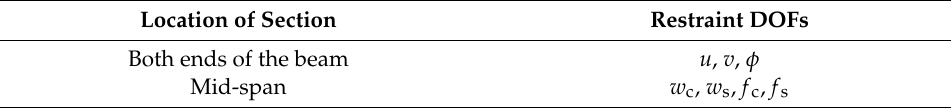
Table 2. Boundary conditions for beam element model.